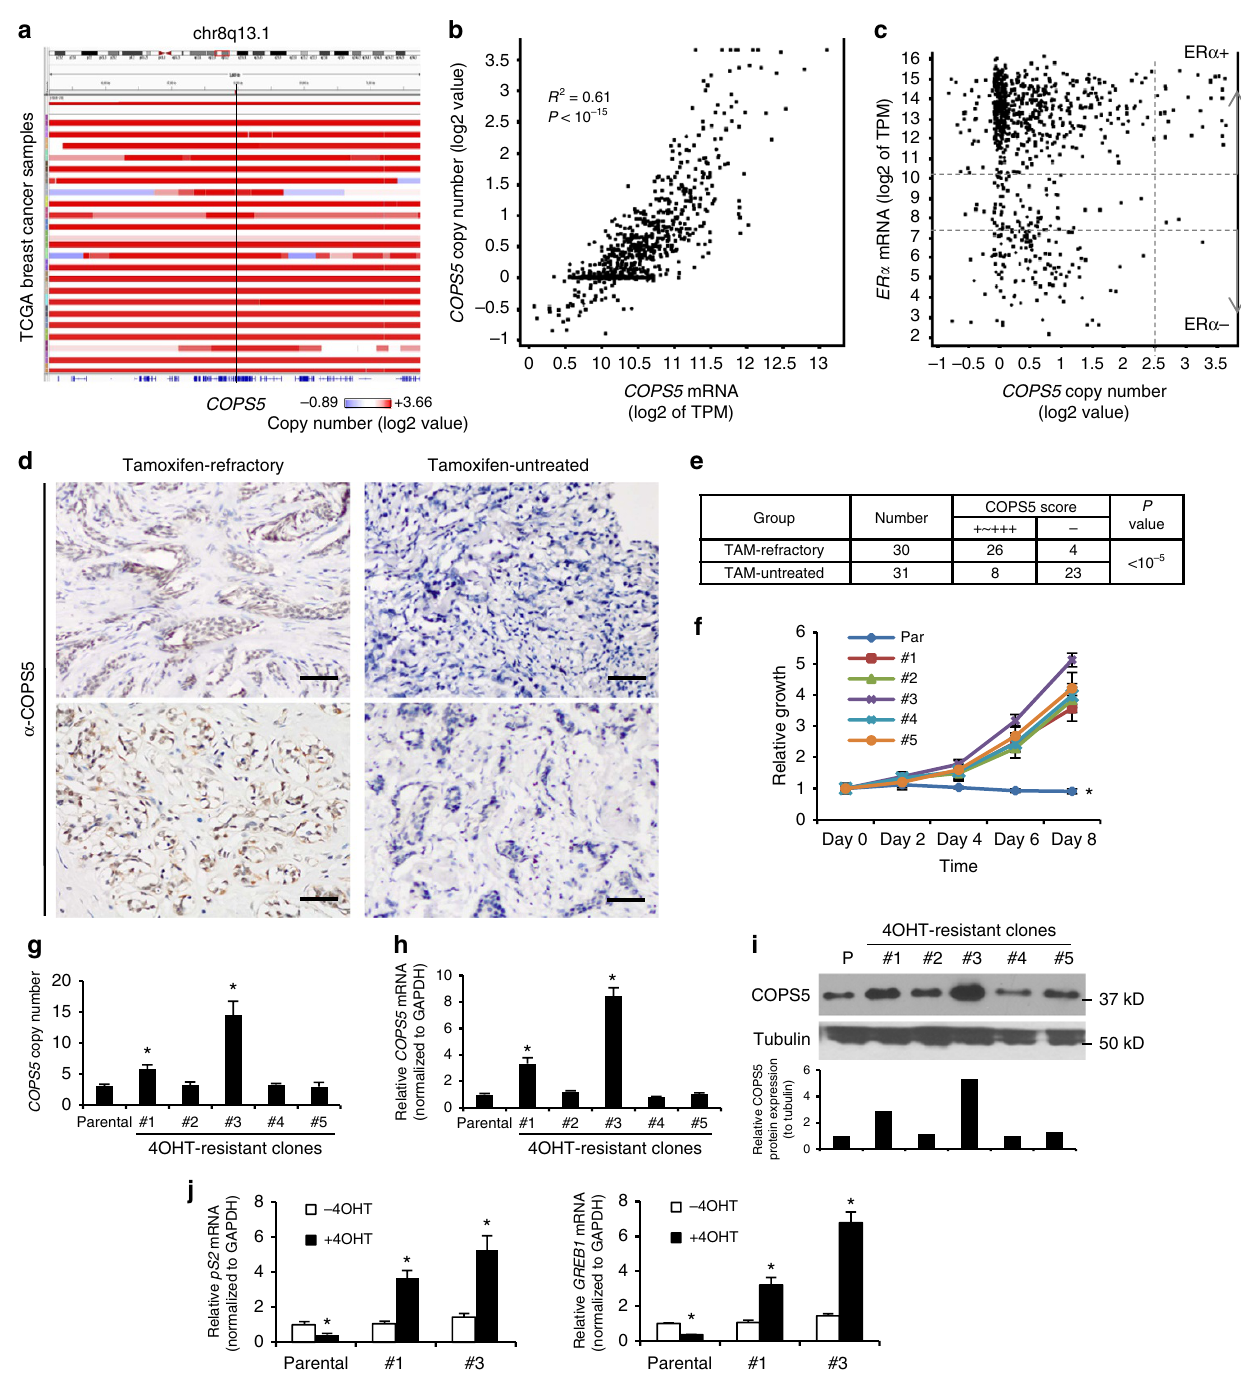
Figure 1 | COPS5 is amplified and overexpressed in ER a þ breast cancer and tamoxifen-resistant MCF7 cells. ( a ) Focal amplification of COPS5 in TCGA breast cancer. Samples were sorted by COPS5 amplitude from the IGV of TCGA portal developed by the Broad Institute. ( b ) Correlation of mRNA level and copy number of COPS5 in TCGA breast cancer samples. ( c ) COPS5 copy number and ER a mRNA expression in TCGA breast cancer samples. ( d ) Immunohistochemistry of COPS5 in representative tamoxifen-untreated and refractory breast cancer. Anti-COPS5 antibody showed positive staining in the nucleus of tumour cells (scale bar, 50 m m). ( e ) w 2 -calculation of the significance of COPS5-overexpression rates in tamoxifen-refractory and tamoxifen- untreated breast tumours. ( f ) Growth curve of parental and tamoxifen-resistant MCF7 clones established by in vitro dose-escalation 4OHT-treatment (refer to Methods) in the presence of 2 m M of 4OHT. Values are normalized to day 0 treatment. *Significant difference compared with other samples ( P o 0.01 at both day 6 and day 8, Student’s t -test). ( g ) Copy number of COPS5 genomic DNA normalized to LINE1 in parental and tamoxifen-resistant MCF7 clones. *Significant difference compared with parental MCF7 ( P o 0.01, Student’s t -test). ( h ) Expression of COPS5 mRNA in parental and tamoxifen-resistant MCF7 clones. Data were normalized to GAPDH and relative to COPS5 expression in the parental cell line which was set as 1. *Significant difference compared with parental MCF7 ( P o 0.01, Student’s t -test). ( i ) Western blot analysis and quantification of COPS5 protein expression in parental and tamoxifen-resistant MCF7 clones. ( j ) Quantitative RT–PCR analysis of ER a target genes pS2 and GREB1 in MCF7 clones after treatment with 500nM 4OHT for 48h. Data are presented as mean þ s.e.m. of three biological replicates. *Significant difference compared with untreated parental MCF7 ( P o 0.01, Student’s t -test). NATURE COMMUNICATIONS|7:12044|DOI: